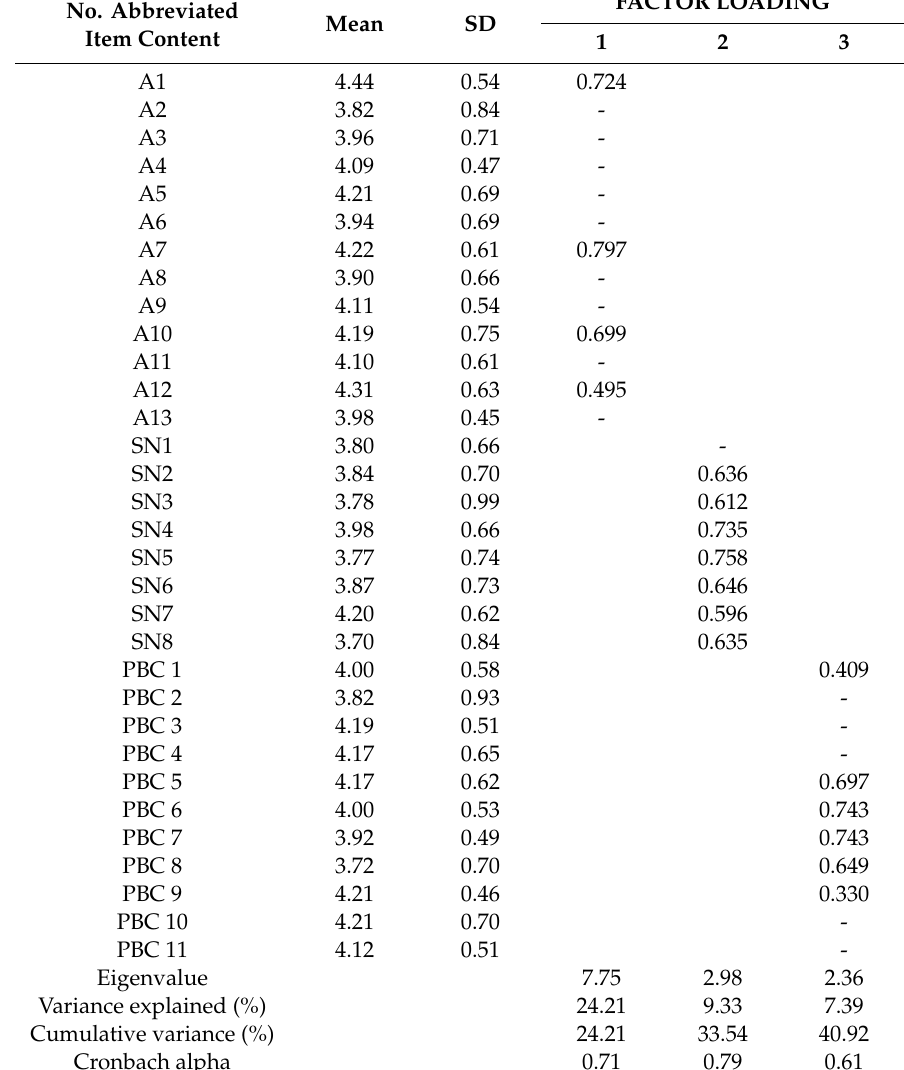
Table 2. Results of Descriptive Statistics, Exploratory Factor Analysis, and Reliability Analysis for EFA Sample ( n =